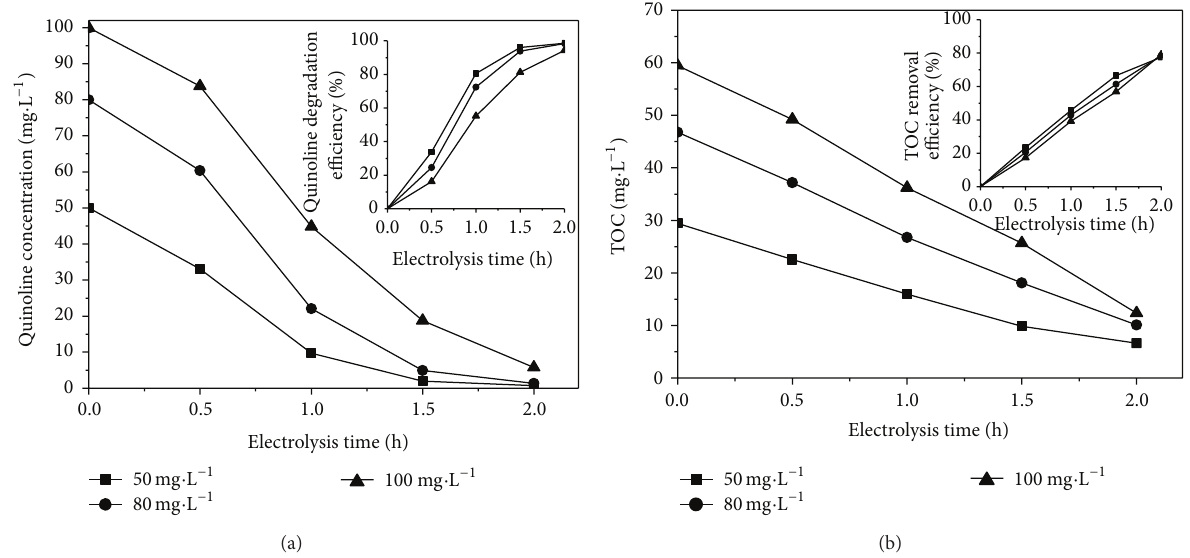
Figure 2: Effect of initial mass concentration on quinoline degradation (a) and TOC removal